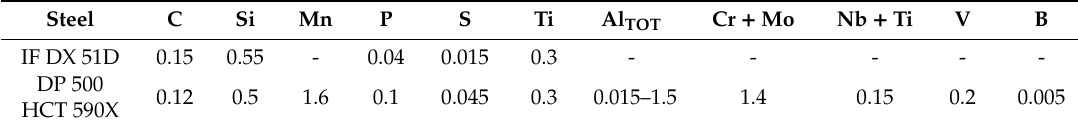
Table 1. Chemical compositions of investigated steels